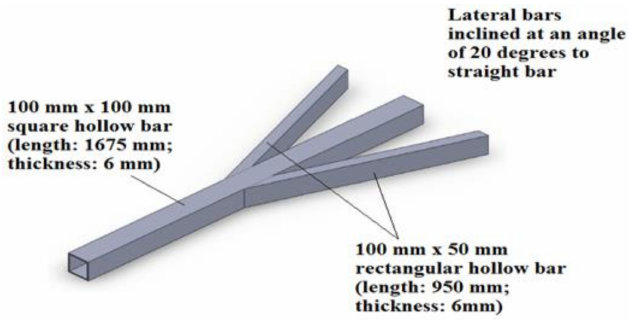
Figure 7. The drawbar.